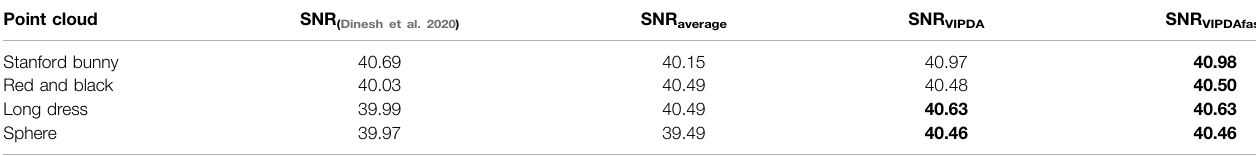
Highest values for each SNR are highlighted in bold.